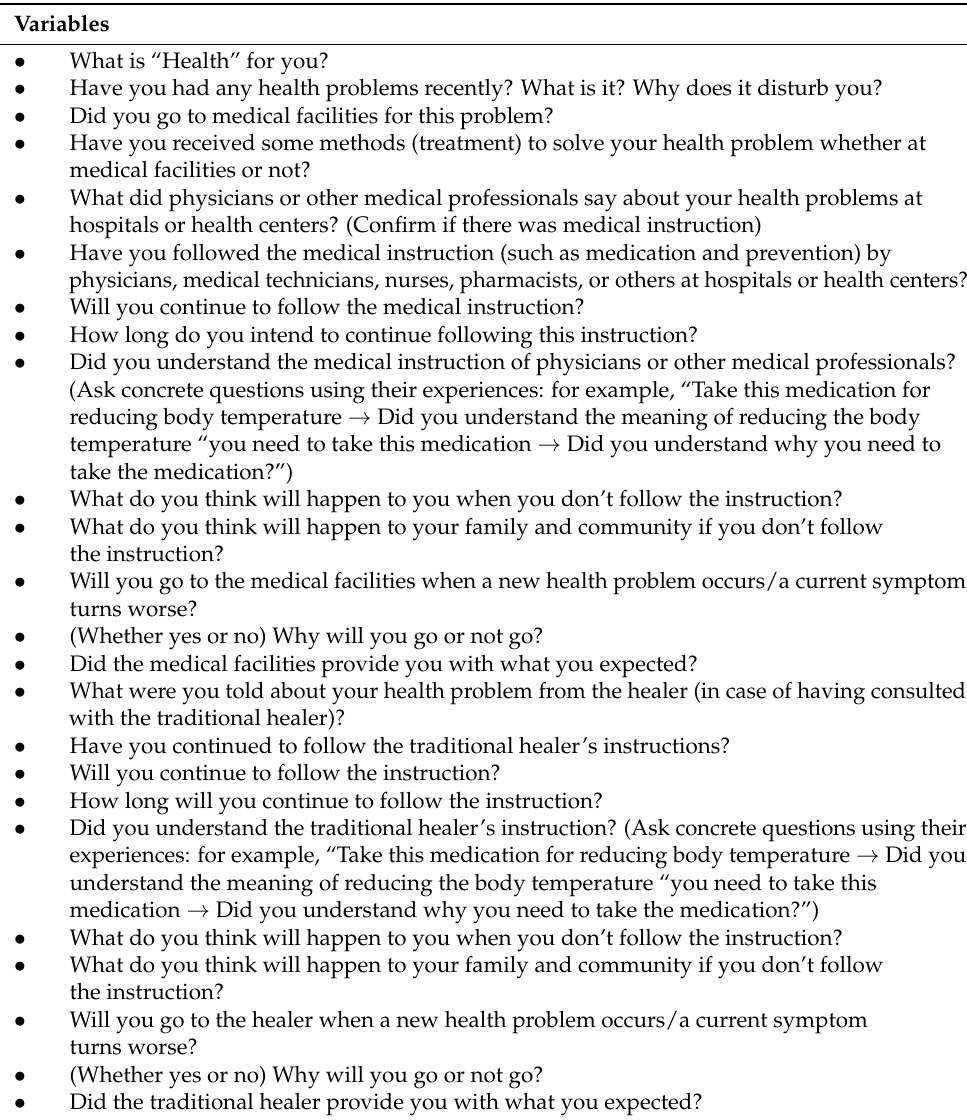
Table 1. Interview